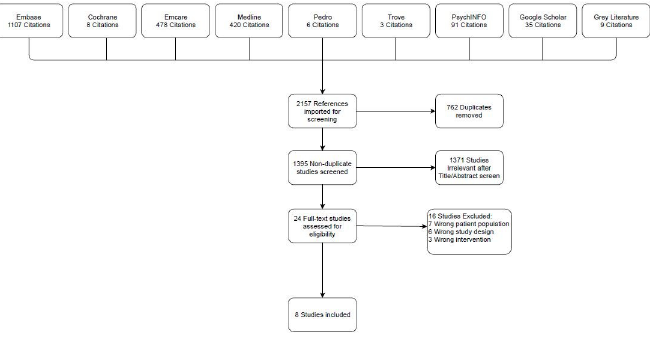
Fig 1. PRISMA flowchart for included studies.